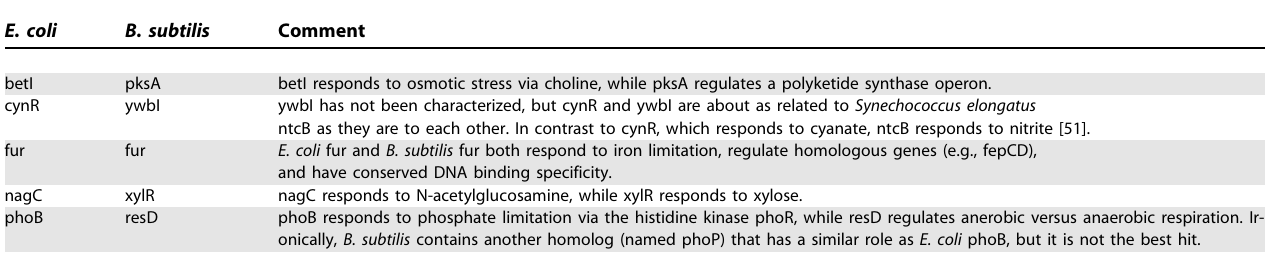
Table 1. Functional Comparison of ‘‘ Orthologous ’’ Transcription Factors from E. coli K12 and B.